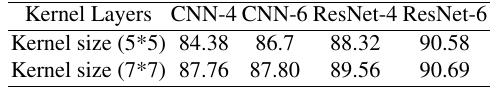
ResNet layers with varying kernel